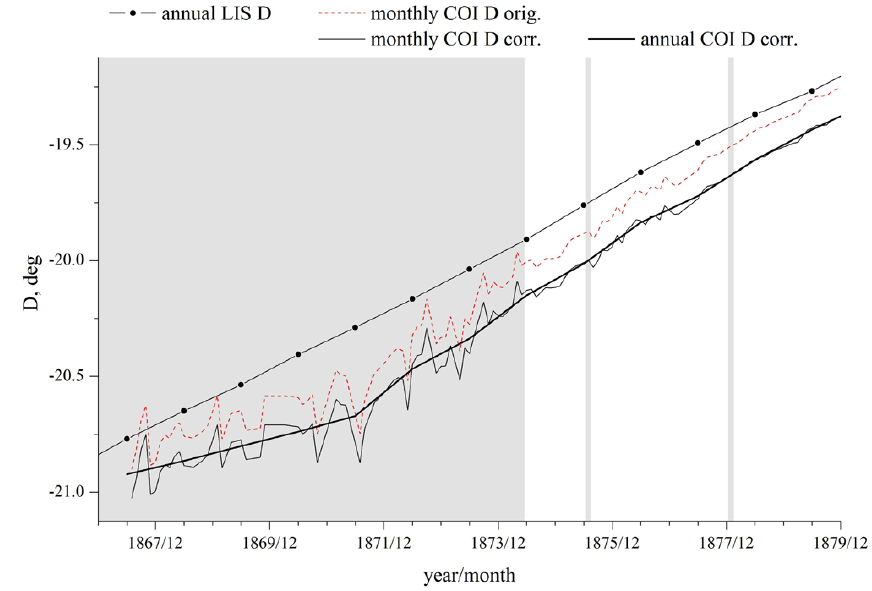
Fig. 13. Comparison of COI D (monthly and annual) and annual LIS D series for the early measurement period. Vertical lines mark epochs of changes in the instruments and initial period of unreliable data for COI D